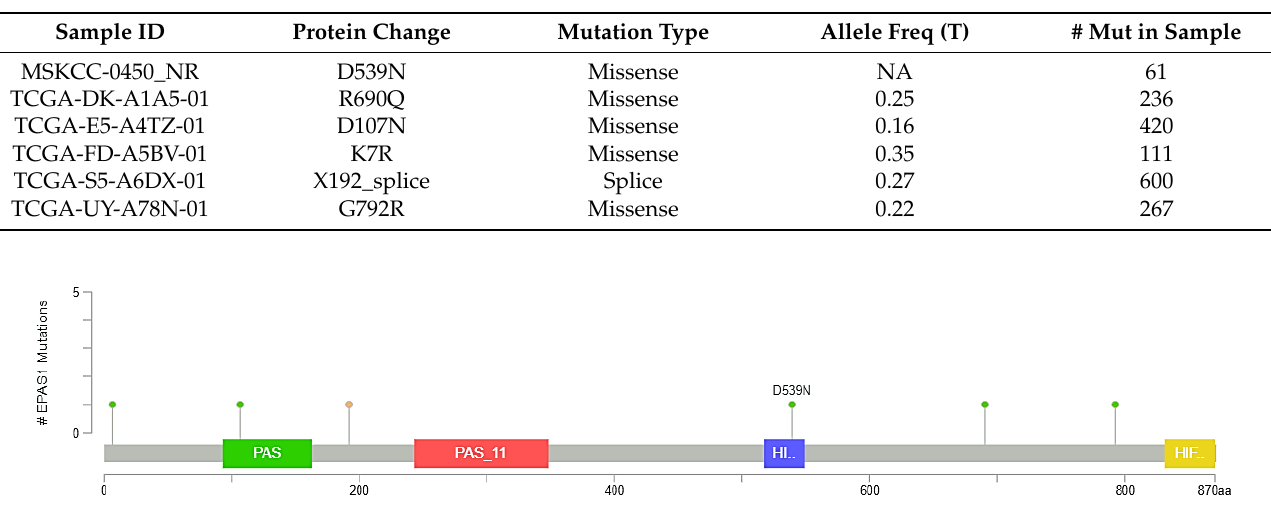
Figure 4. Lollipop plot of EPAS1 mutations in MSK/TCGA 2020 cohort (n = 476). # Number of mu- tations